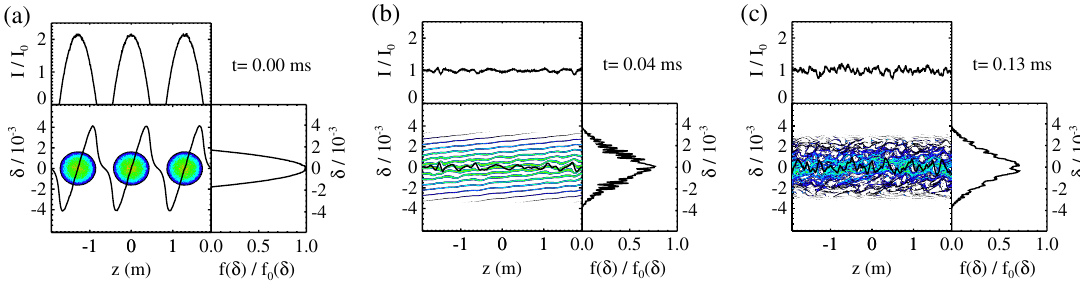
FIG. 6. Snapshots of the simulated time evolution of the multistream instability for an 40 Ar 18 þ beam with a space charge parameter ¼ 0 : 47 for the initial microbunches (a). The onset of the instability of U sc ¼ 0 : 3 for the coasting beam and the bunching factor of B f between the inner filaments (b) and the fluctuations after saturation (c) is clearly